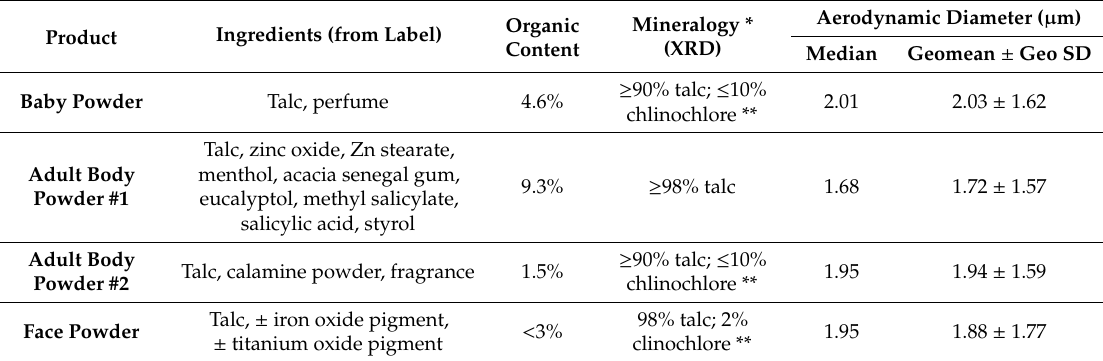
Table 2. Physical-chemical characteristics of cosmetic talc products used in the present study. ParticlesizemeasurementsofthetalccloudweremadeusingtheAerodynamicParticleSizeratadistance of 69 cm from the bottle top, inside the laboratory chamber at 27 ◦ C and 21% RH (Relative